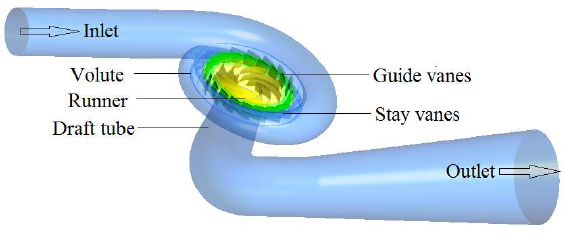
Figure 1. Representation of the main zones of the pump turbine model.